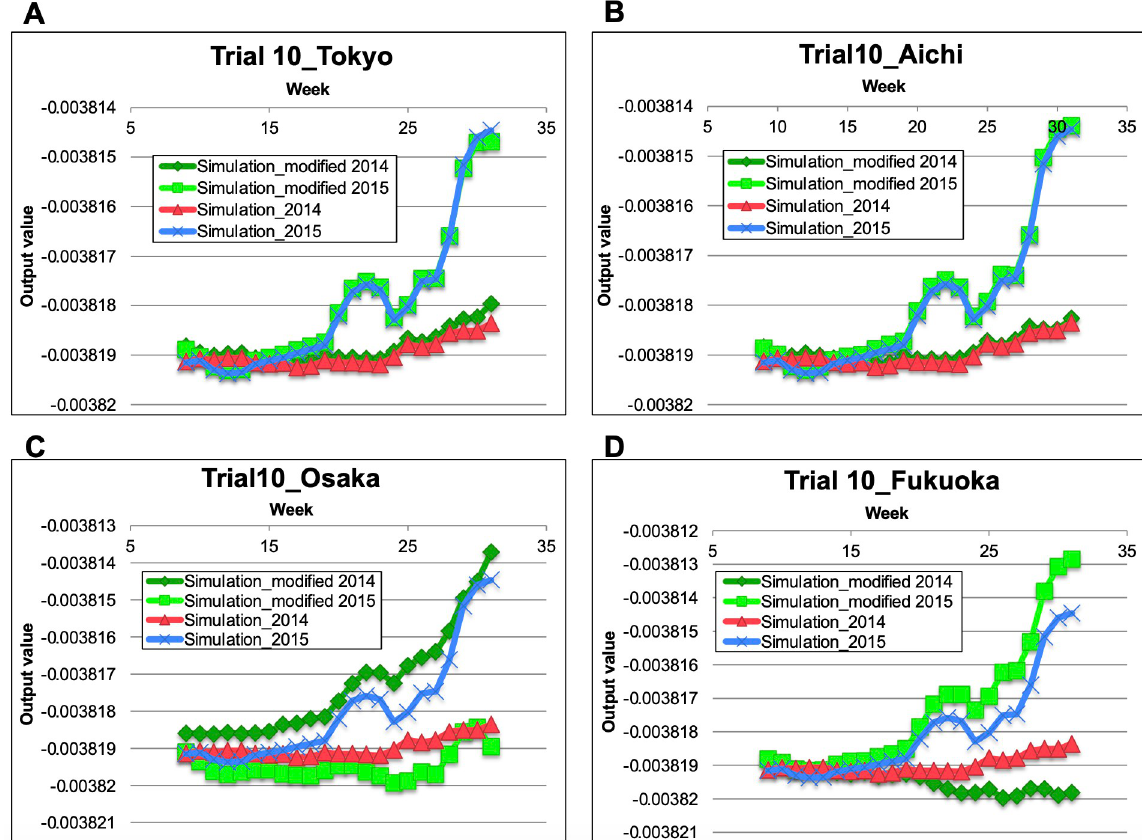
Fig 6. Example of simulation results of each prefecture’s epidemic by using the modified data. The three independently trained models were inputted with the pediatric sentinel data of 2014 and 2015 after replacing some data in Tokyo (A), Aichi (B), Osaka (C), and Fukuoka (D). Diamonds: modified 2014 data, squares: modified 2015 data, triangles: original 2014 data, crosses: original 2015 data.